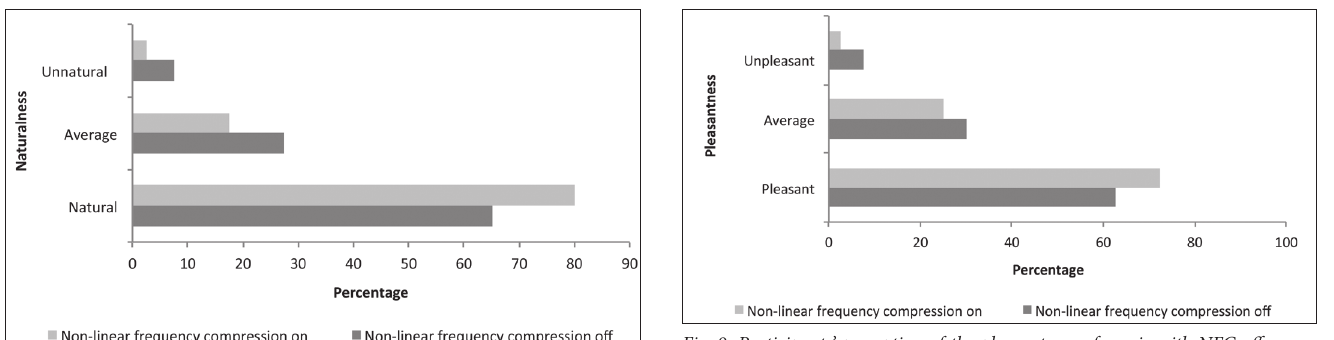
Fig. 9. Participants’ perception of the pleasantness of music with NFC off versus NFC on.